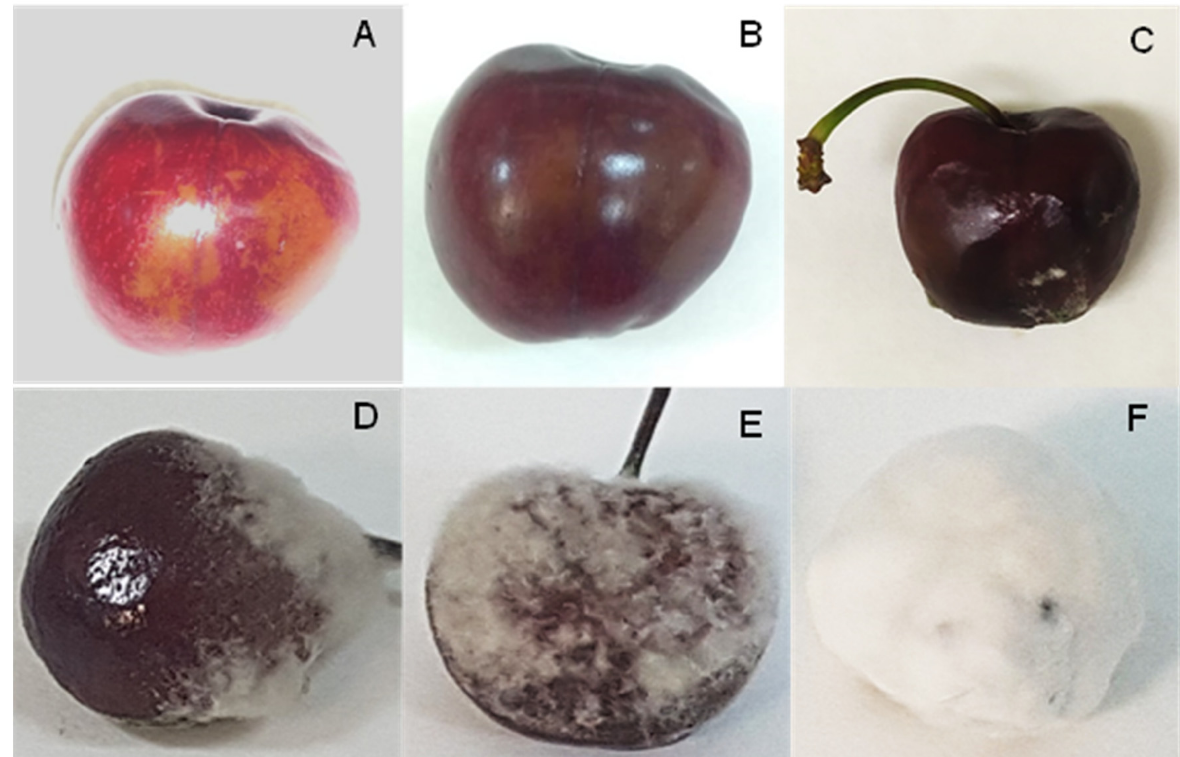
Figure 1. Evolution of the symptomatology of ‘aqueous spot’ disease. ( A , B ) partial decolouration and translucent cherry skin; ( C ) softening of tissues, initial development of white/grey mycelium; ( D , E ) development of white mycelium; ( F ) complete coverage of a cherry by white mycelium.